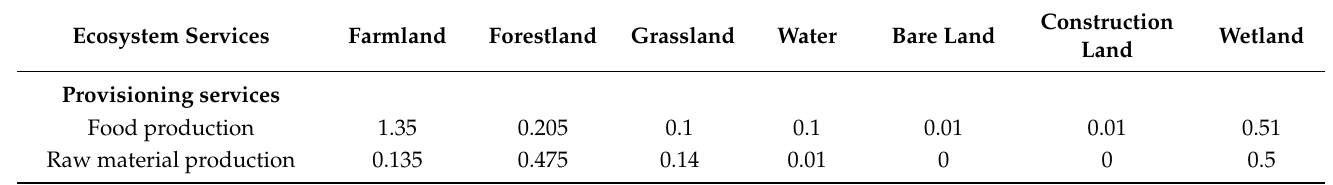
Table 1. Ecological service value per unit area.